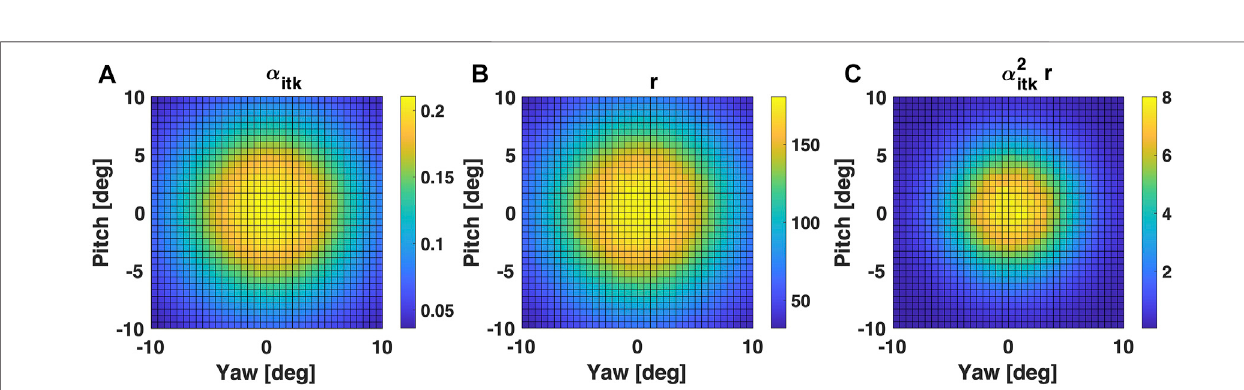
Frontiers in Physics |